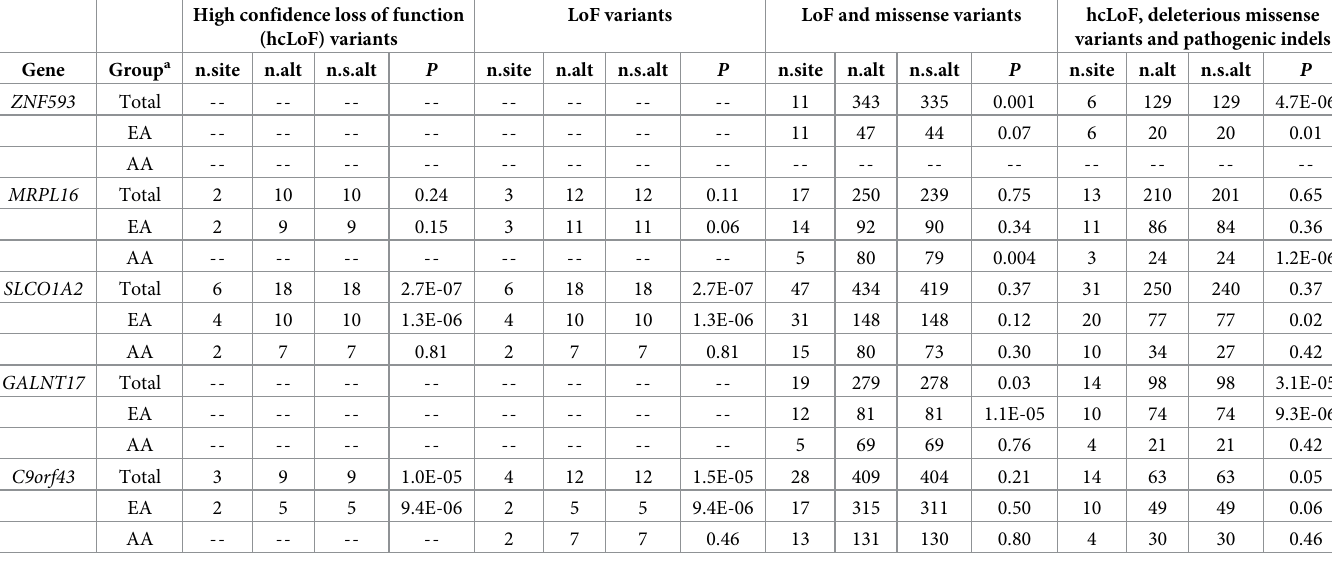
Table 3. Significant and suggestive genes (P < 10 − 5 ) associated with MEAN handgrip strength in TOPMed when aggregating rare variants with a minor allele count (MAC) greater or equal to 2 and a minor allele frequency (MAF) less than 1% using SKAT-O. High confidence loss of function LoF variants LoF and missense variants hcLoF, deleterious missense (hcLoF) variants variants and pathogenic indels Gene Group a n.site n.alt